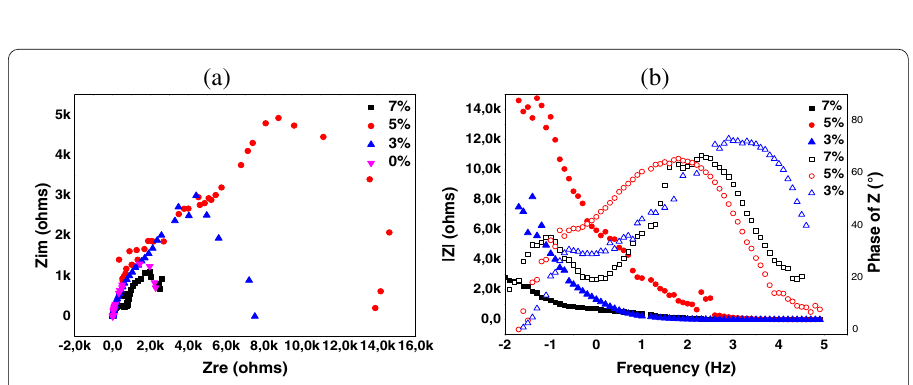
Fig. 9 The impedance curve of the different molybdate concentration according to the representation of a Nyquist plots and b Bode plots in 3.5% NaCl